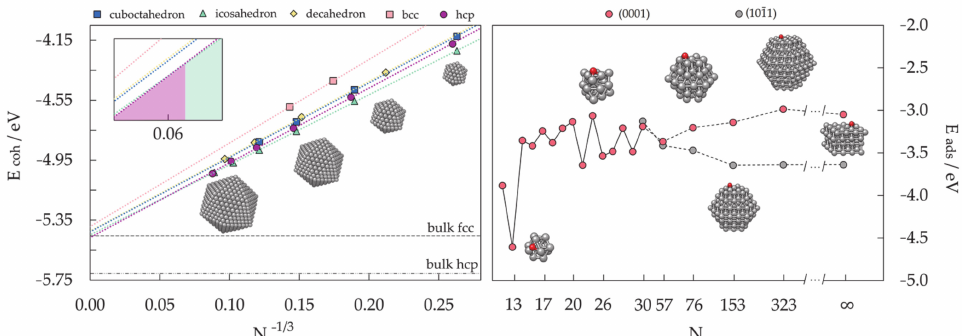
Figure 12. Linear fitting of the cohesive energies of Co NPs of varying morphologies with 55 < N < 1500 atoms with an insert capturing the crossover between the icosahedral and hexagonal shape ( left ) [239]. Progression of oxygen adsorption energies from nonscalable (2 < N < 50) to scalable regime of Co NPs with hexagonal symmetry ( right ); extended slab models are denoted as ∞